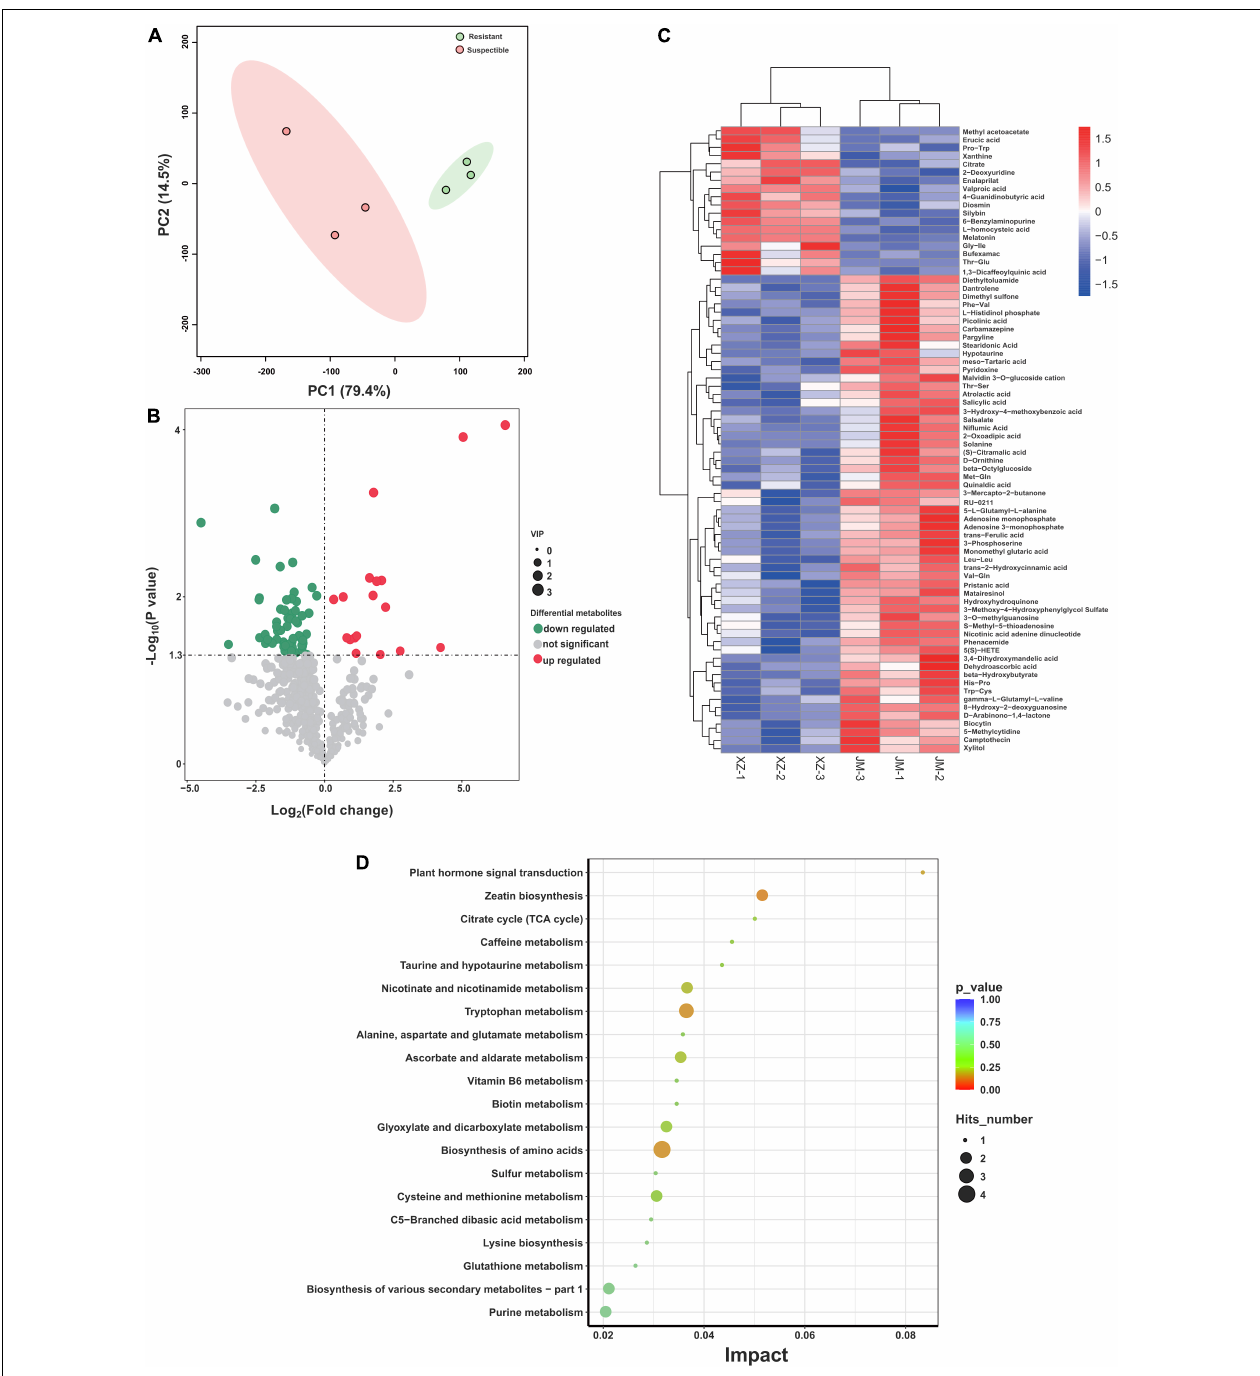
FIGURE 4 | Analysis of exudation profiles between resistant and susceptible cotton cultivars. (A) PCA plot of the root exudate profiles of two cotton cultivars. (B) The comparison of volcano plots of differentially expressed metabolites between the resistant and susceptible cultivars. (C) Heatmap of identified differentially expressed metabolites from resistant and susceptible samples. (D) Pathway enrichment analysis of differential metabolites from resistant and susceptible cultivars. XZ is the resistant cultivar and JM is the susceptible